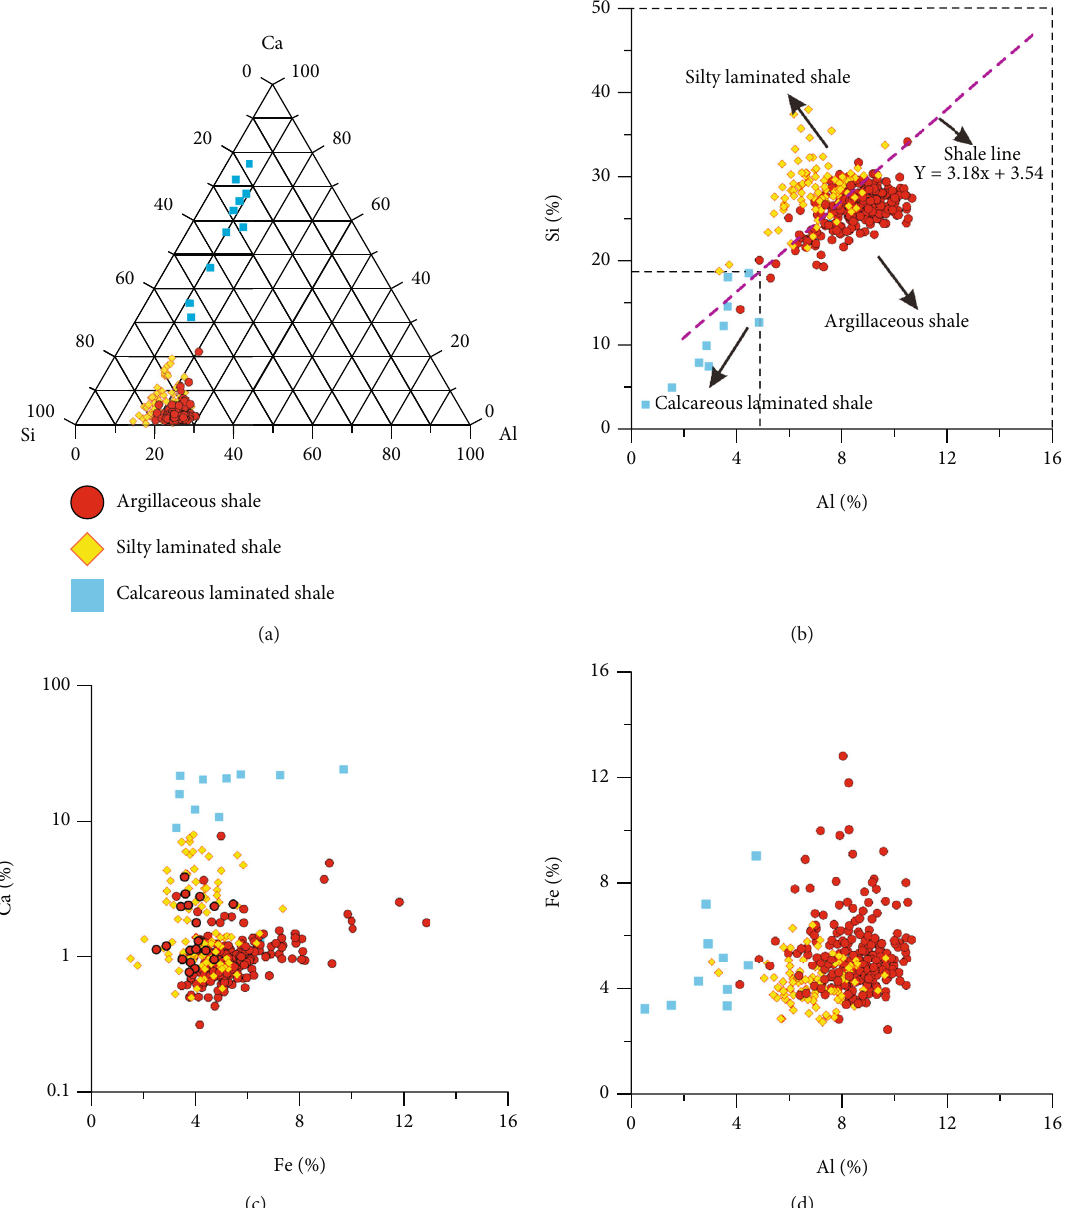
Figure 8: Element content relationship of di ff erent lithologies in Well